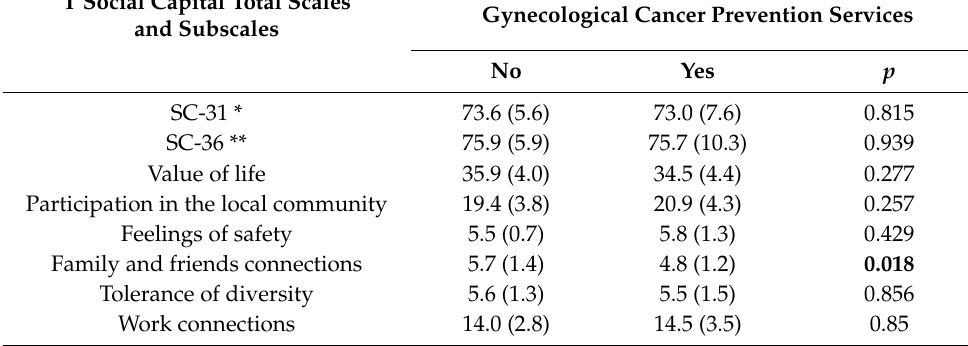
Table 7. Mean differences in social capital and its components between the students who had and those who had not been informed of prevention services.